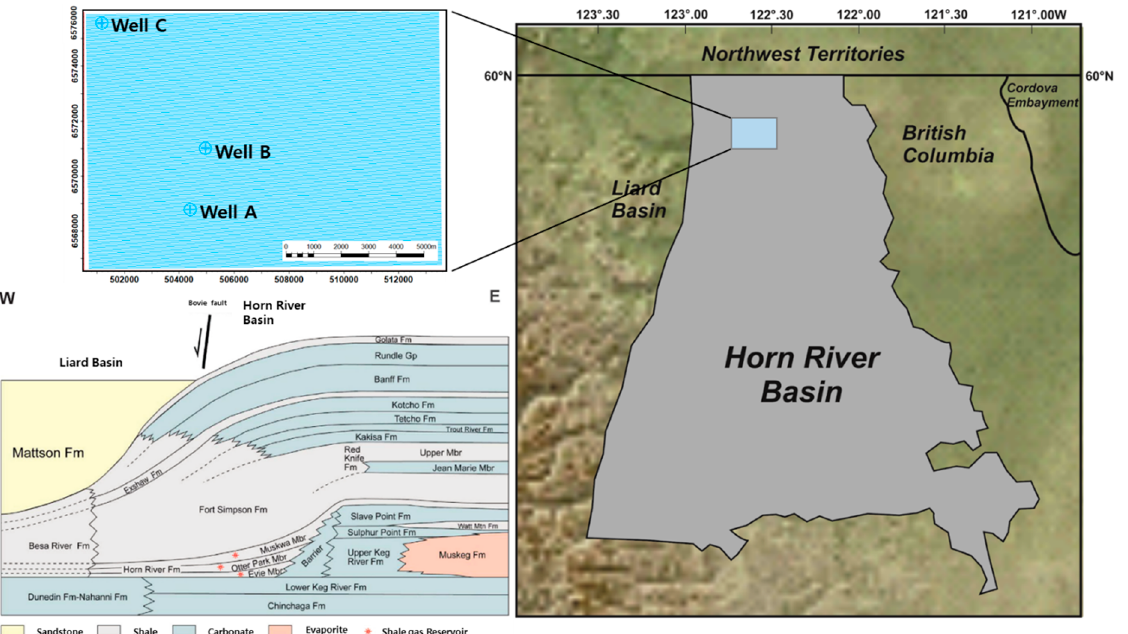
Figure 1. Well location in the Kiwigana Field of the Horn River Basin. Note the relationship between the Horn River Basin and the Liard Basin in terms of their location and stratigraphic cross section